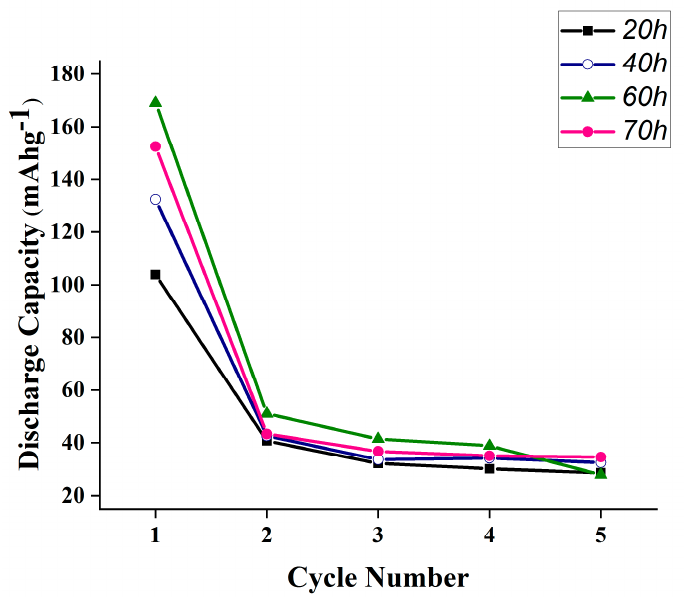
Figure 11. Discharge capacity of the electrodes made from stoichiometric TiFe milled products after 20, 40, 60, and 70 h of milling as a function of cycle number.